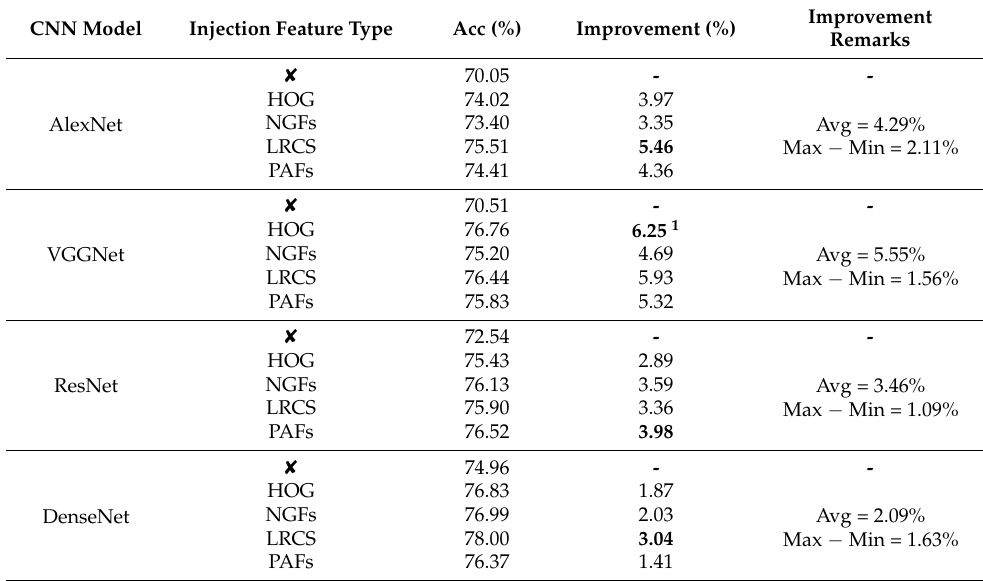
Table 4. SAR ship classification results on the OpenSARShip-1.0 dataset with and without injection. CNN